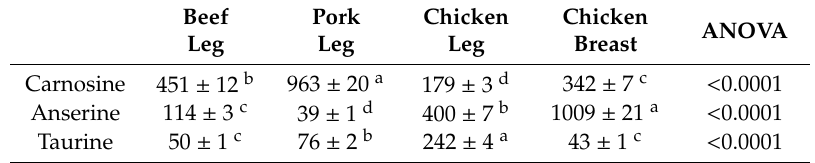
Table 7. Intake of carnosine, anserine, and taurine in mice fed various meat protein species.